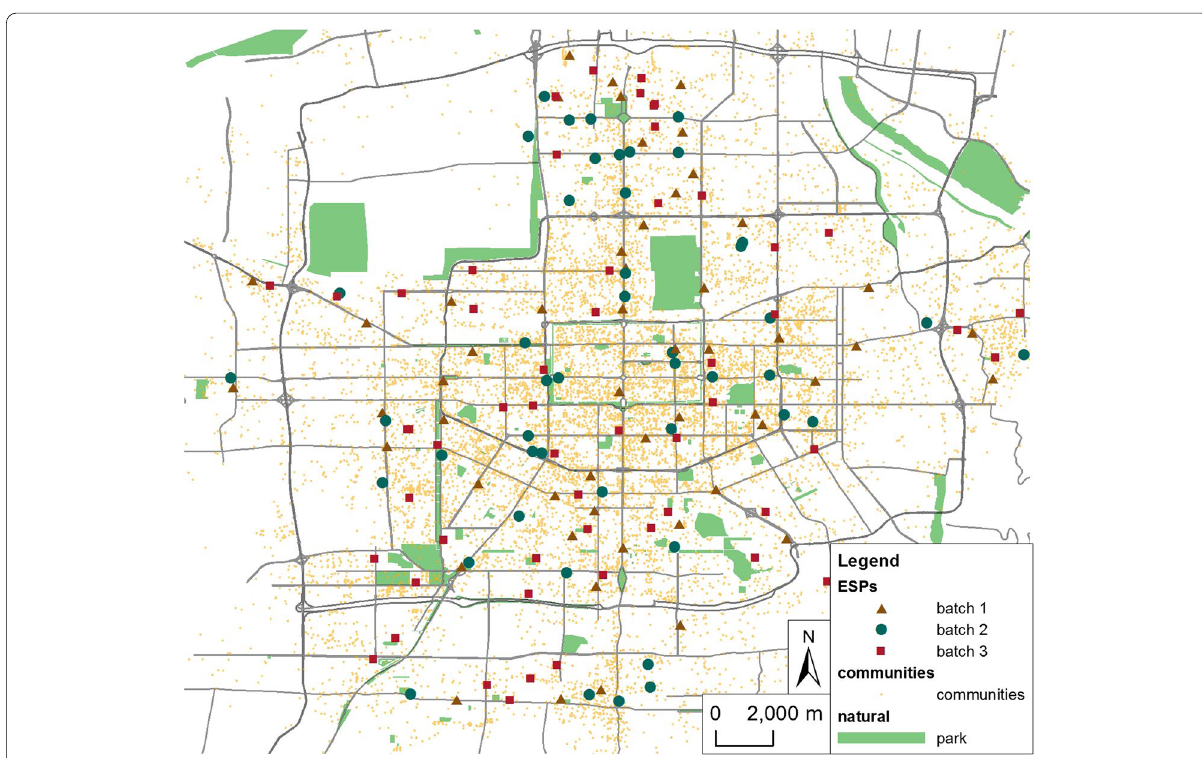
Fig. 2 Distribution of governmental reserved vegetable delivery points and residential community points in